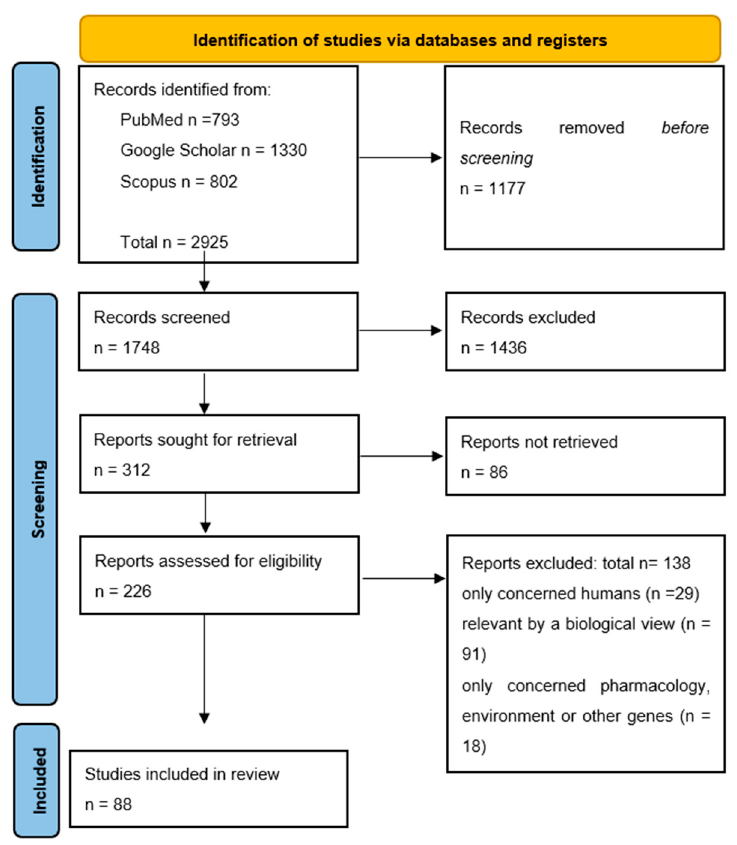
Figure 1. Identification of studies regarding mcr genes in livestock animas via databases using PRISMA guidelines. From: Page MJ, McKenzie JE, Bossuyt PM, Boutron I, Hoffmann TC, Mulrow CD, et al. The PRISMA 2020 Statement: An Updated Guideline for Reporting Systematic Reviews. BMJ 2021;372:n71. doi:10.1136/bmj.n71.